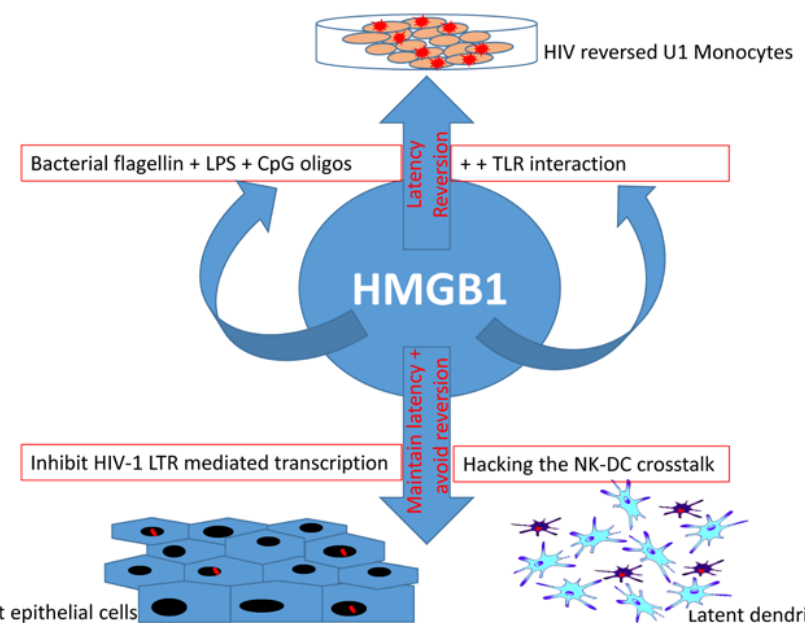
Figure 2. Dual role of HMGB1 in HIV latency. HMGB1 protein not only helps maintain viral latency in epithelial cells and dendritic cells, but also helps reverse HIV latency in U-1 monocytes. This reversal is associated with TLR interaction with bacteria-derived molecules (flagellin, LPS, and CpG oligos) that play a major role in HMGB1-associated reversal, suggesting the importance of foreign (bacterial) components in HIV reversal. However, as an indication of a dual role of HMGB1 protein family, latency is maintained and its reversion is prevented through the inhibition of HIV-1 LTR-mediated transcription and hacking the natural killer (NK) cells and dendritic cell (DC) crosstalk in latent epithelial cells and dendritic cells, respectively.